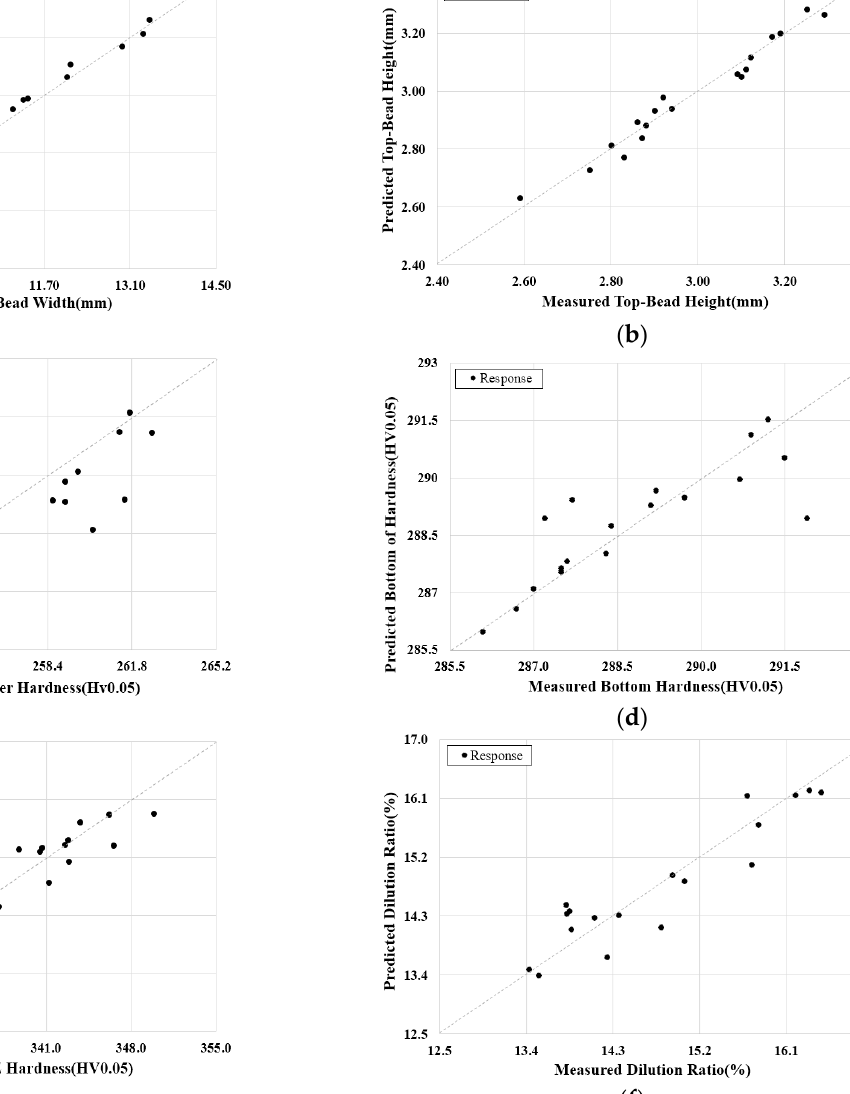
Figure 9. Comparison between measured and predicted welding factors according to mathematical model: ( a ) Top-Bead width, ( b ) Top-Bead height, ( c ) Upper hardness, ( d ) Bottom hardness, ( e ) HAZ hardness, and ( f ) Dilution Ratio.